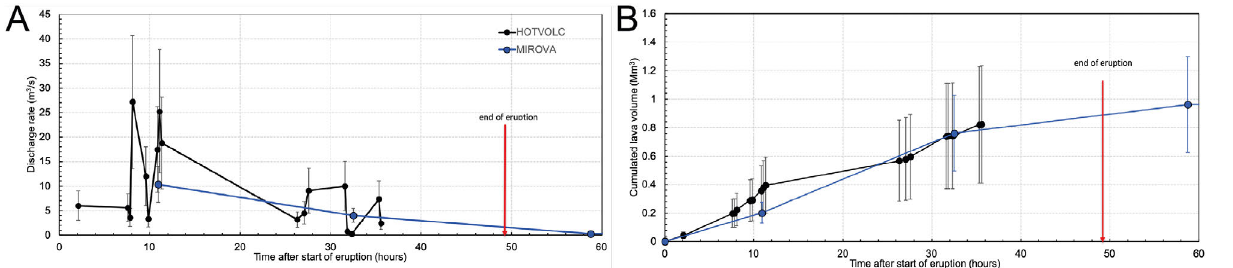
Figure 4: [A] Time-average discharge rate as a function of time since the start of the eruption, and [B] lava cumulative volume obtained by HOTVOLC and MIROVA . Uncertainties are 35 % for MIROVA and 50 % for HOTVOLC . the seismic crises which gave little reaction time to produce the short-term hazard